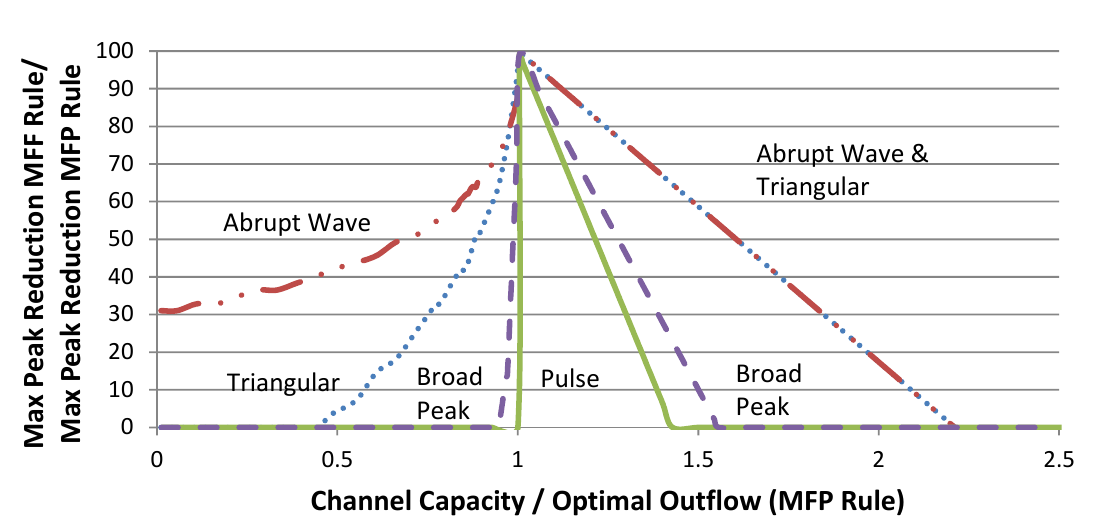
Figure 7. Efficiency of the MFF rule in reducing peak flow normalized by the peak flow reduction of the MFP rule, for varying channel capacities normalized by the ideal peak outflow of the MFP